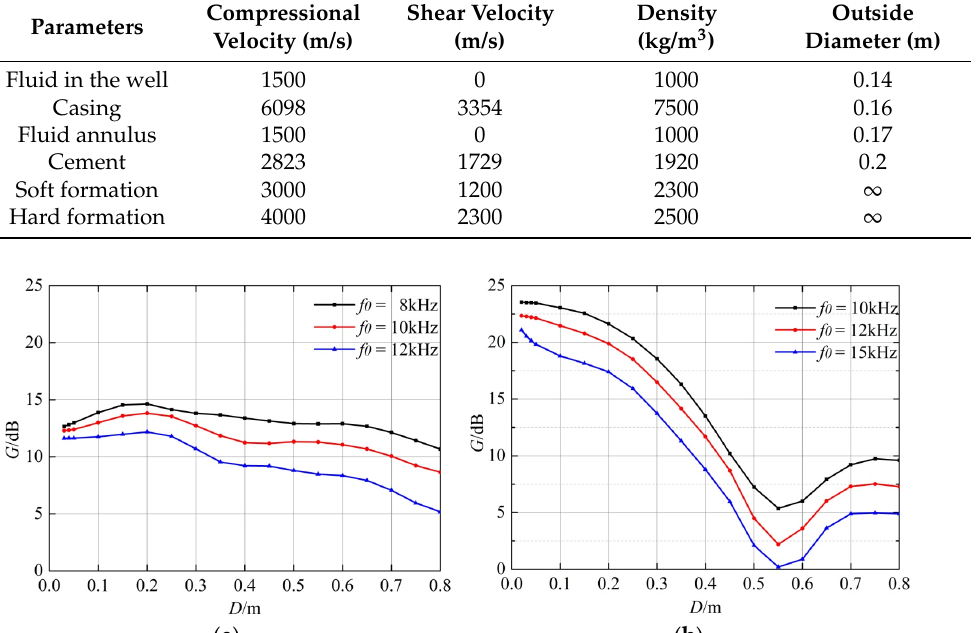
Figure 5. Structural diagram and part of the actual picture of the logging tool. 4. The Design of the Dual ‐ Source Transducer Excitation Circuit Traditional transducer excitation circuits produce positive pulse signals of high volt ‐ age, which are not suitable for the designed dual ‐ source tool [27,28]. First, this tool needs to carry out two excitation signals of opposite polarities and a good consistency. Second, the amplitude, frequency, and delay time of the excitation signals should be adjusted pre ‐ cisely. Lastly, to ensure that the sound wave can pass through the casing to reach the for ‐ mation and be received by receiving transducers, the transmitters should have sufficient emission power. Therefore, a dual ‐ source transmitting circuit is designed. The schematic diagram of the dual ‐ source excitation circuit is shown in Figure 6. It consists of a transmitting controller, two digital ‐ to ‐ analog converters, two power amplifi ‐ ers, a high ‐ voltage power supply, and a series of high ‐ voltage storage capacitors. The transmitting controller uses a high ‐ speed digital signal processor (DSP). The workflow is as follows. First, the DSP collects control signals, which are mainly about the amplitude, polarity, frequency, and delay time of the excitation signals from the central control sys ‐ tem by the Controller Area Network bus. Second, the DSP waits for the fire sync command generated by signal acquisition circuits. When the command comes, it acquires the wave data stored in its FLASH storage and outputs these data into the digital ‐ to ‐ analog con ‐ verters. Third, these core circuits produce low ‐ voltage excitation signals, which are imme ‐ diately amplified by power amplifiers (a kind of class AB push–pull excitation circuit) to several thousands of volts. Lastly, high ‐ voltage excitation signals are applied to transmit ‐ ting transducers to excite acoustic signals. The frequency and amplitude of the high ‐ volt ‐